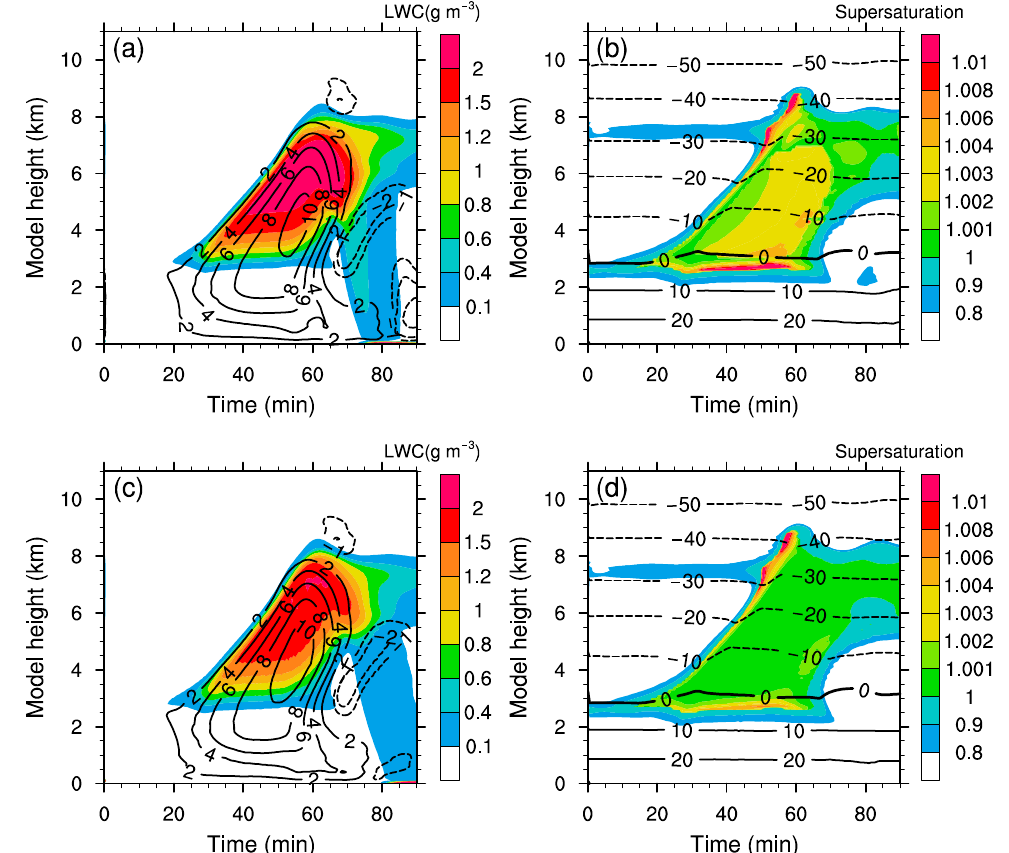
Figure 6. Spatial and temporal evolution of the thermodynamic variables with the Eulerian advection scheme ( a , b ) and the Lagrangian advection scheme ( c , d ). ( a , c ) Liquid water content (shaded area) and vertical wind (solid and dashed lines) (unit: g · m − 3 and m · s − 1 ) as a function of time and height. ( b , d ) Supersaturation ratio (shaded area) and temperature (solid and dashed lines) (unit: none and degree Celsius) as a function of time and height.